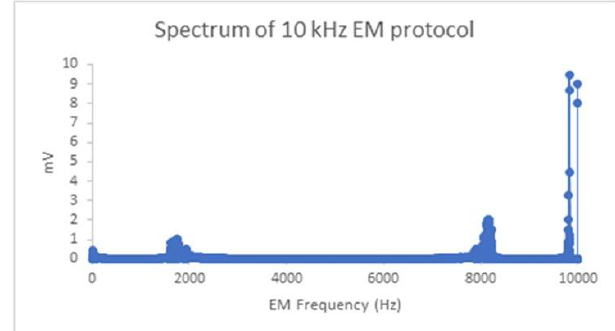
Figure 2 : Spectrum of the alternating 10 kHz the electromagnetic field (EMF) excitation protocol (by Fast Fourier Transform of the EMF profile recorded on an oscilloscope). EM: Electromagnetic; Hz: